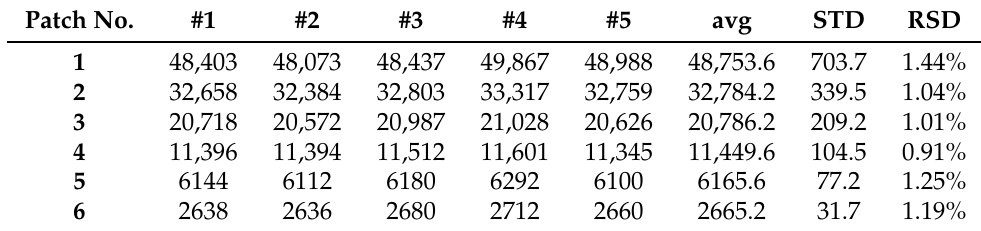
Table 6. The consistency of images in five consecutive TLS